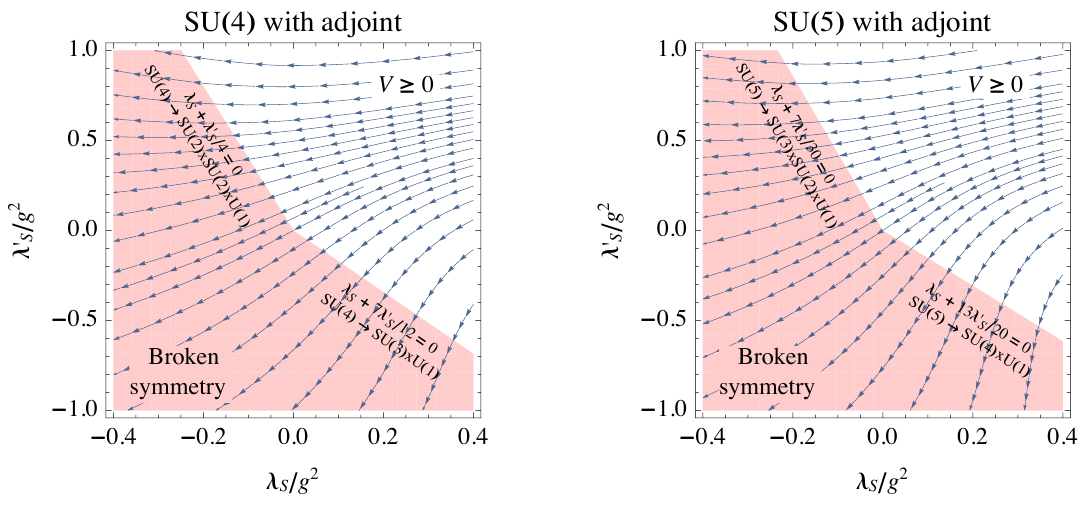
Figure 3 . Coleman-Weinberg symmetry-breaking patterns for a SU( N ) gauge theory with a scalar in the adjoint: the RGE (cid:13)ow towards low energy of its quartics (cid:21) S and (cid:21) 0 instability conditions in both their branches, leading to the two di(cid:11)erent breaking patterns discussed in the